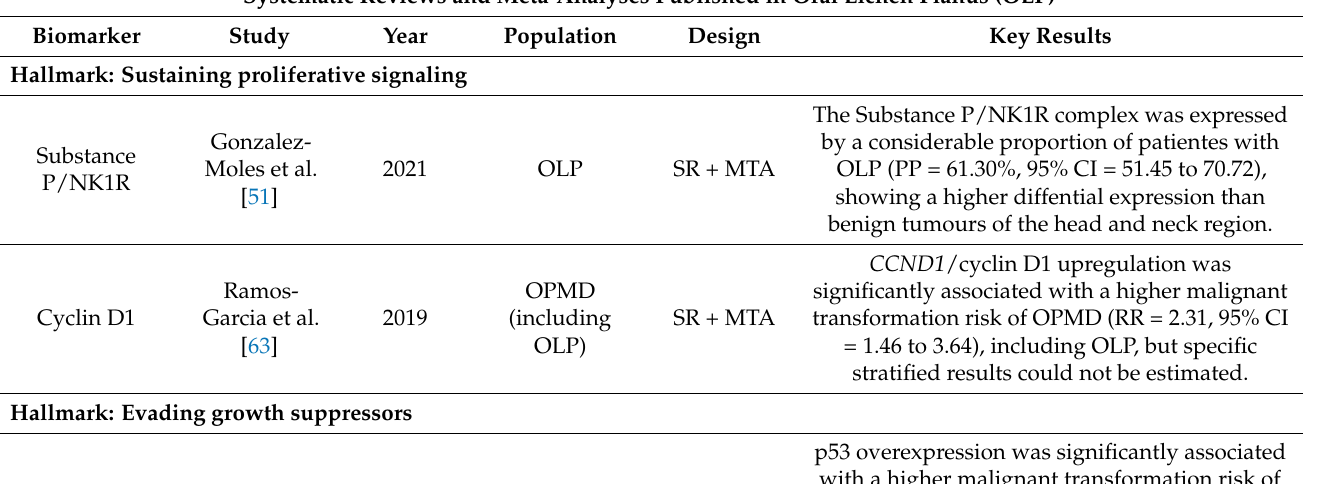
Table 3. Secondary-level systematic reviews and meta-analyses published ( n =